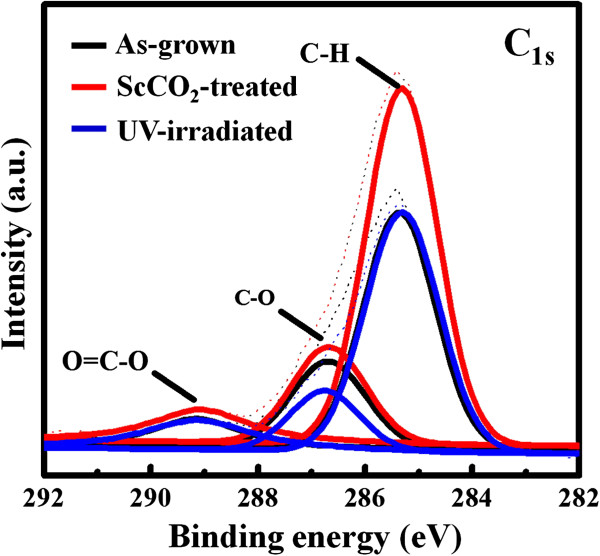
XPS surface analysis results, in terms of spectra for C 1 s . Of the as-grown, ScCO2-treated, and ScCO2-treated TiO2 nanotubes of 100 nm in diameter with UV light irradiation.